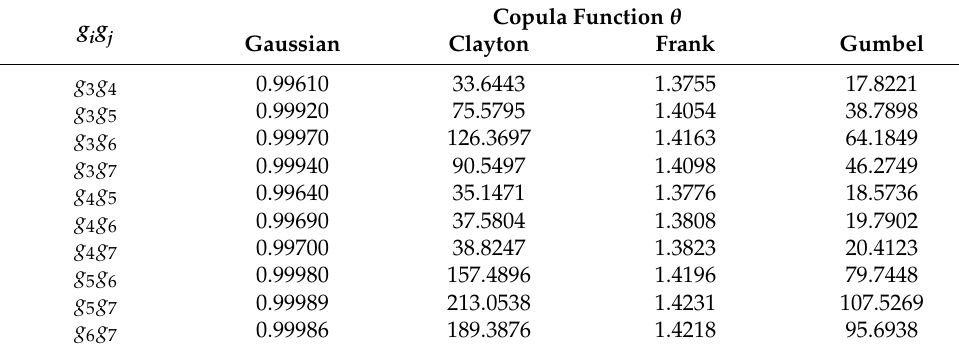
Table 5. Relevant parameter values of the alternative Copula function.